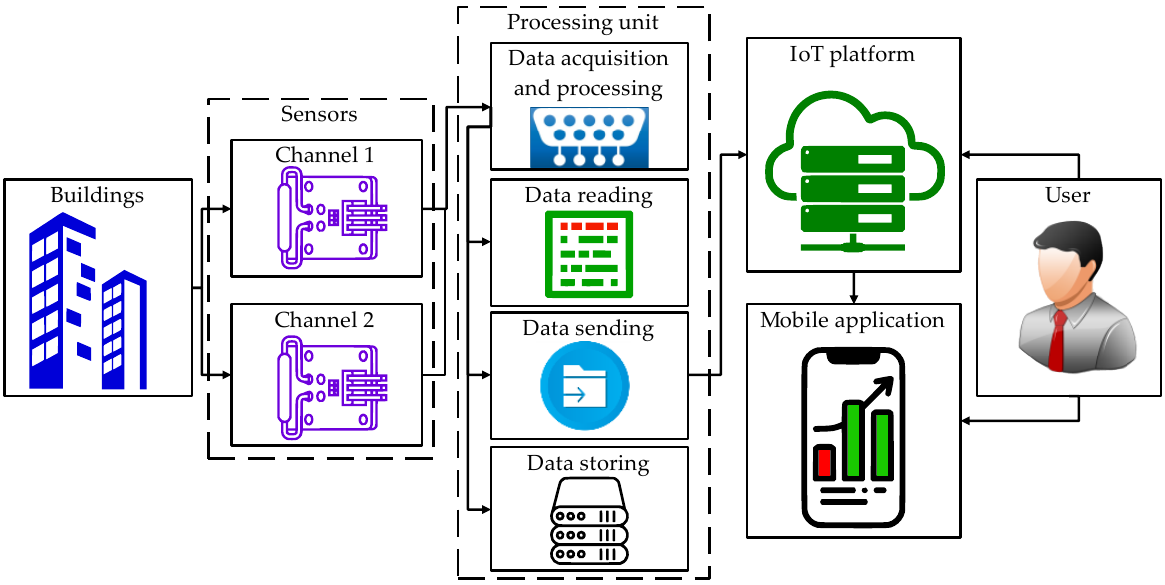
Figure 1. General diagram of the alternating current electrical parameter-monitoring system.